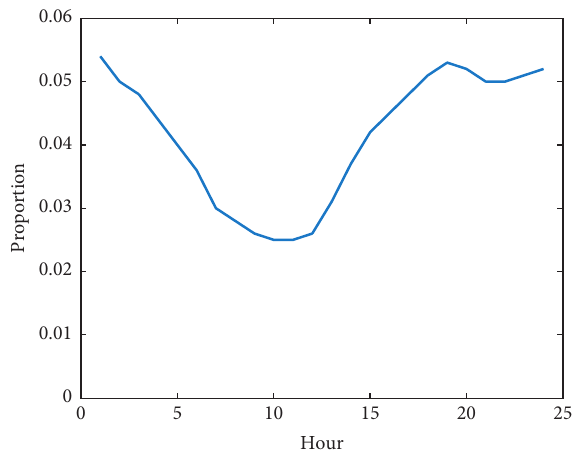
Figure 3: Hourly distribution of user